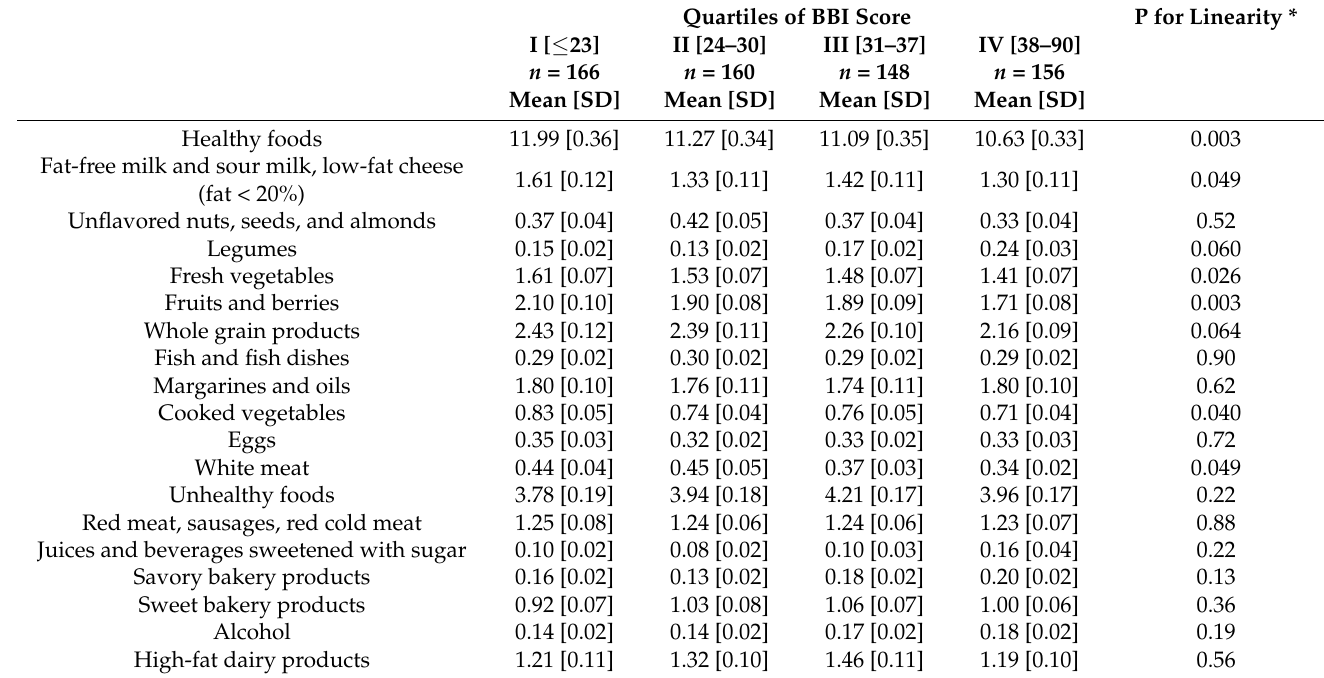
Table 3. Average consumption of healthy and unhealthy food groups consumed per day according to quartiles of the Bergen Burnout Indicator (BBI) score.